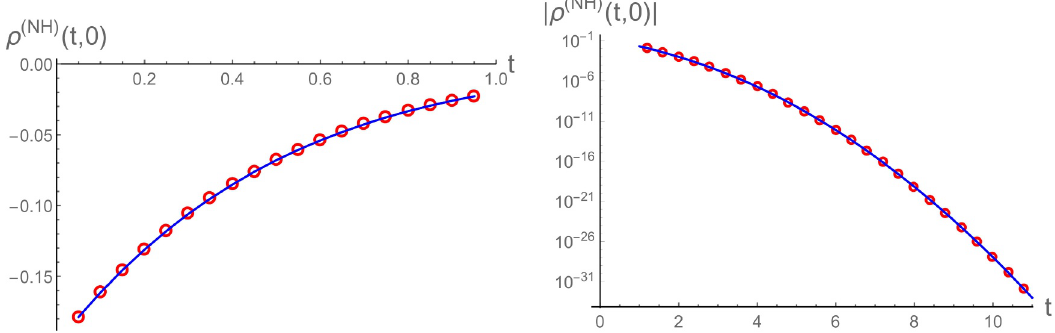
Figure 16 . Left: same as figure 15, but now for the nonperturbative series at t < t c . Right: result of the Borel resummation of the nonperturbative series for t > t ρ ( NH ) ( t, 0) determined by a numerical integration along γ that the negative (positive) lateral Borel resummation corresponds to the choice of γ ( γ ) integration contour in the original integral, with the average of both corresponding ( − , +) to the γ integration paths. We plot an example of this agreement in figure , γ ( − , − ) (+ , +)